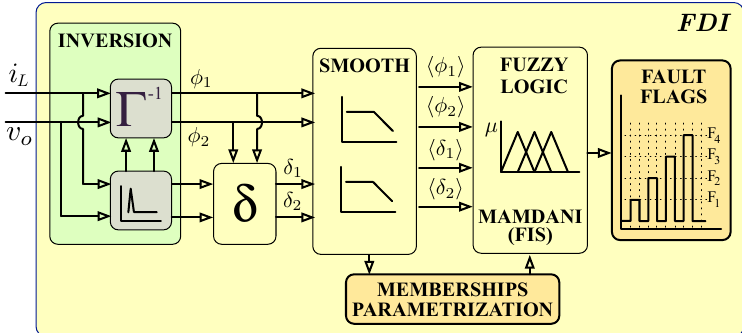
Figure 6. Overview of the implemented Fault Detection and Isolation (FDI)